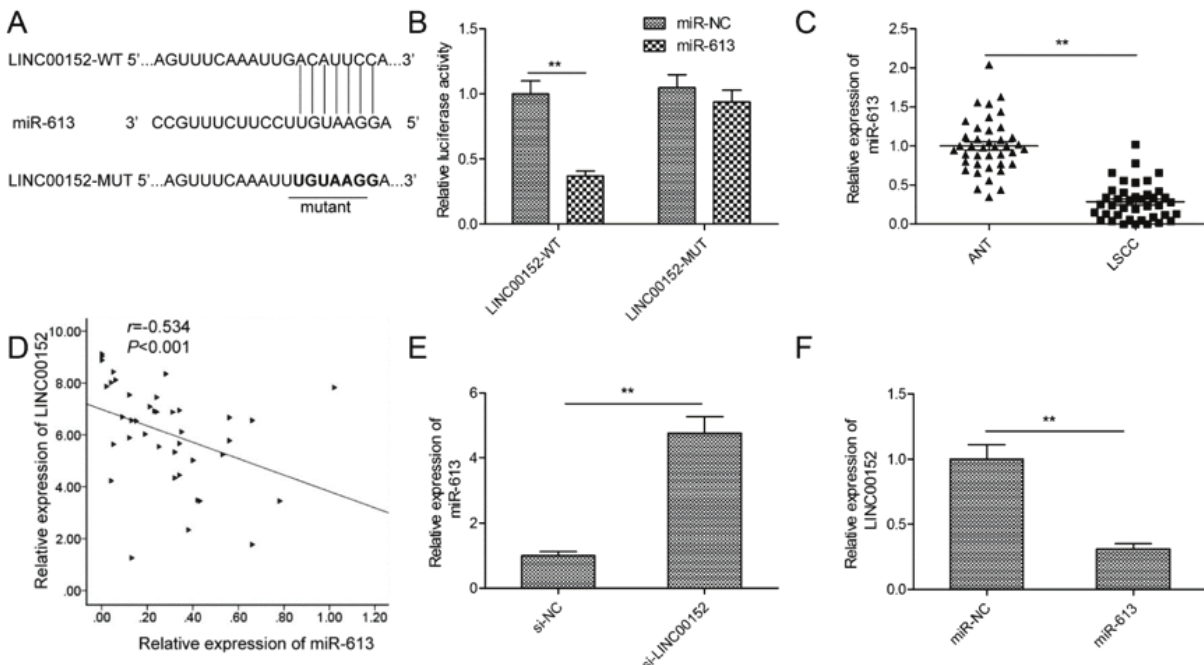
Figure 4: LINC00152 regulates miR-613 expression by direct interaction in LSCC cells. (A) The complementary binding of miR-613 and wild/ mutant type of LINC00152 is shown. WT: Wild-type; MUT: mutant-type. (B) Overexpression of miR-613 significantly reduced the luciferase activity of WT-LINC00152 group. (C) qRT-PCR analysis showed the expression of miR-613 in LSCC tissue and adjacent normal tissue (ANT). (D) The correlation between LINC00152 and miR-613 was analyzed in LSCC tissues by Spearman’s test. (E) The expression of miR-613 was examined in TU212 cells transfected with si-NC or si-LINC00152 by qRT-PCR. (F) The expression of LINC00152 was examined in TU212 cells transfected with miR-613 mimics or miR-NC by qRT-PCR. *P < 0.05; **P< 0.01.